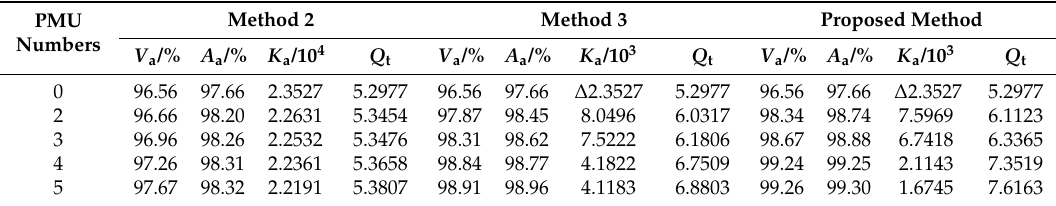
Table 5. The results of state estimation of different cases in 14 bus system.